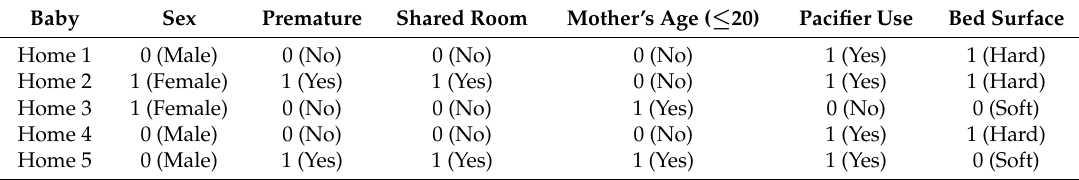
Table 5. Description of the main factors that are characteristic of the babies participating in the study.